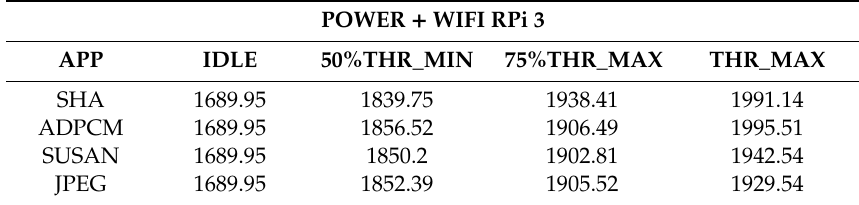
Table 5. Power Consumption RPI 3 + Wifi.